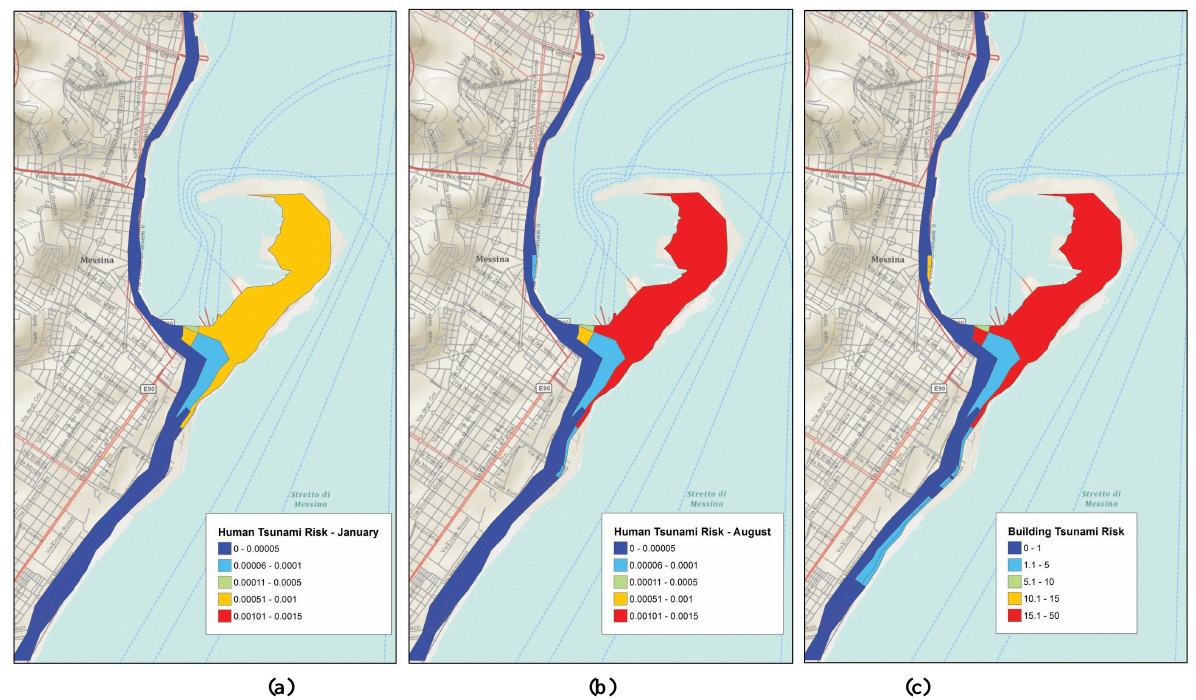
Fig. 7. Human Tsunami Risk HTR j in terms of persons (a) in January and (b) in August, and (c) Building Tsunami Risk BTR j i economic value (Euro) in each j -th section fraction in the i -th TRZ i ( j = 1 , 54 and i = 1 , 2 ,